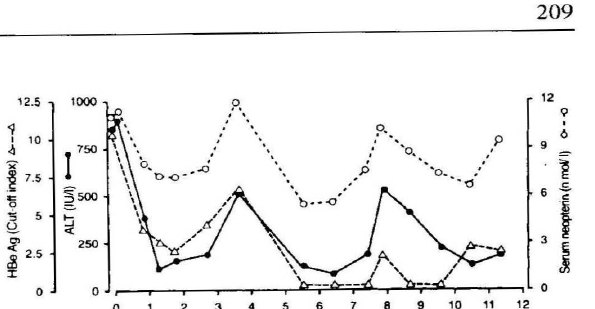
Figure 1. Monitoring of serum neopterin (nmolfl), serum HBeAg (cut off index), and ALT levels (lUll) in a chronic hepatitis B patient (~0.1 ) showing several acute exacer bations of liver injury for a 12-months period. Semm neopterin levels changed dynamically relative to HBeAg and ALT levels.